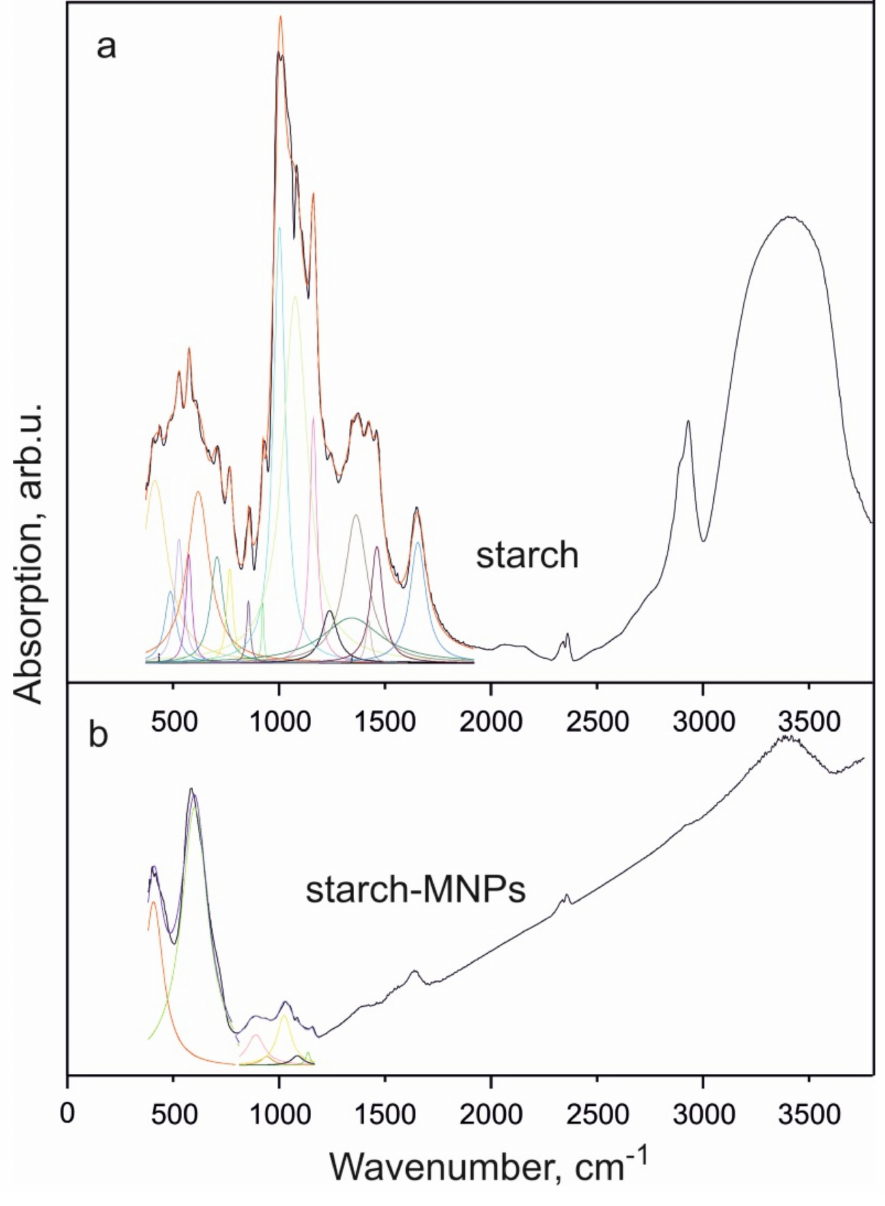
Figure 3. ( a ) FTIR spectrum of starch at T = 300 K and division of the spectral region at 380–1900 cm − 1 into components. ( b ) FTIR spectrum of starch-MNPs and division of the spectral region at 380–1200 cm − 1 into